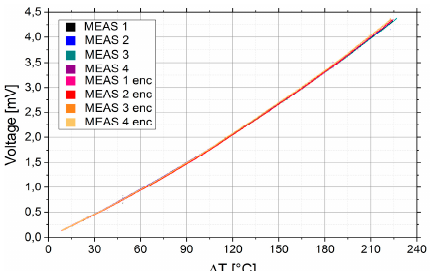
Figure 3. Graph of the recorded voltage over the temperature difference between junction and the connection for the uncoated (abbreviated with MEAS 1–4) and top coated (abbreviated with MEAS 1–4 enc)